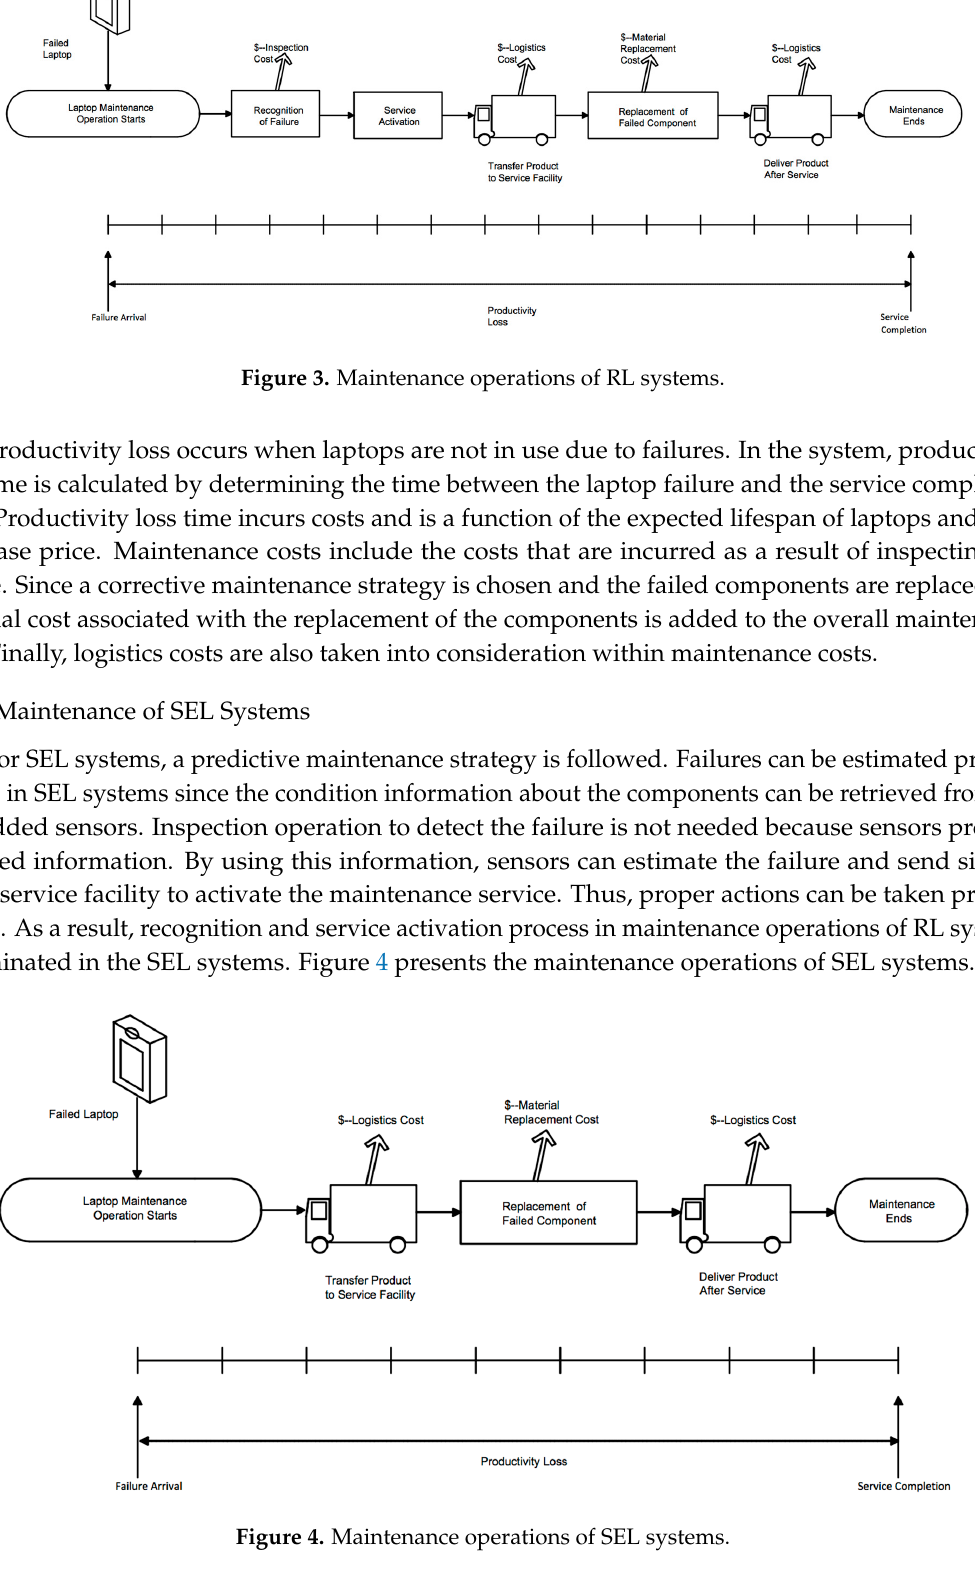
Figure 4. Maintenance operations of SEL systems.